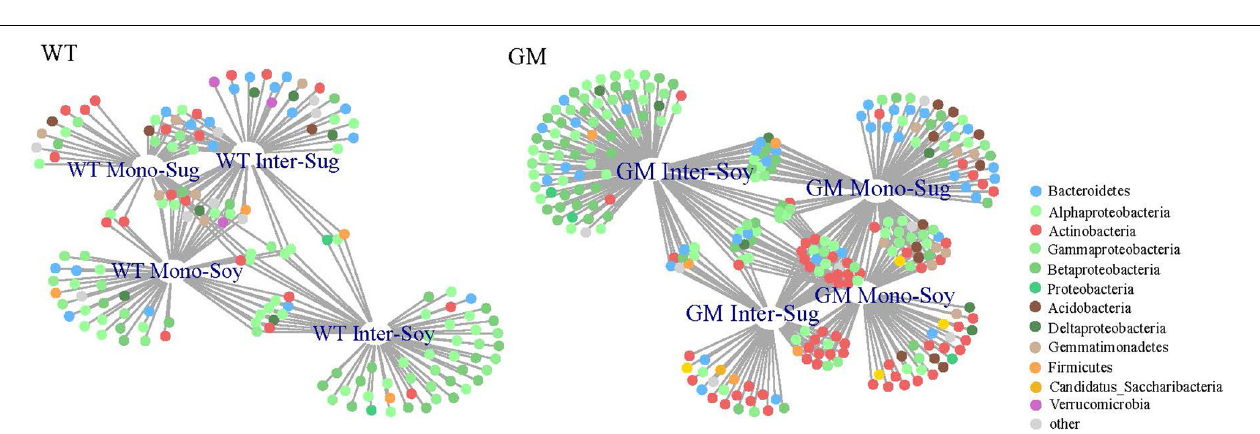
FIGURE 4 | (A) Relative abundance of different phyla in each pattern. (B) Distance-based Redundancy analysis of different patterns (dot), abundant classes (rhombus), and environmental factors (arrows) indicates the dominant communities and influential environmental factors.